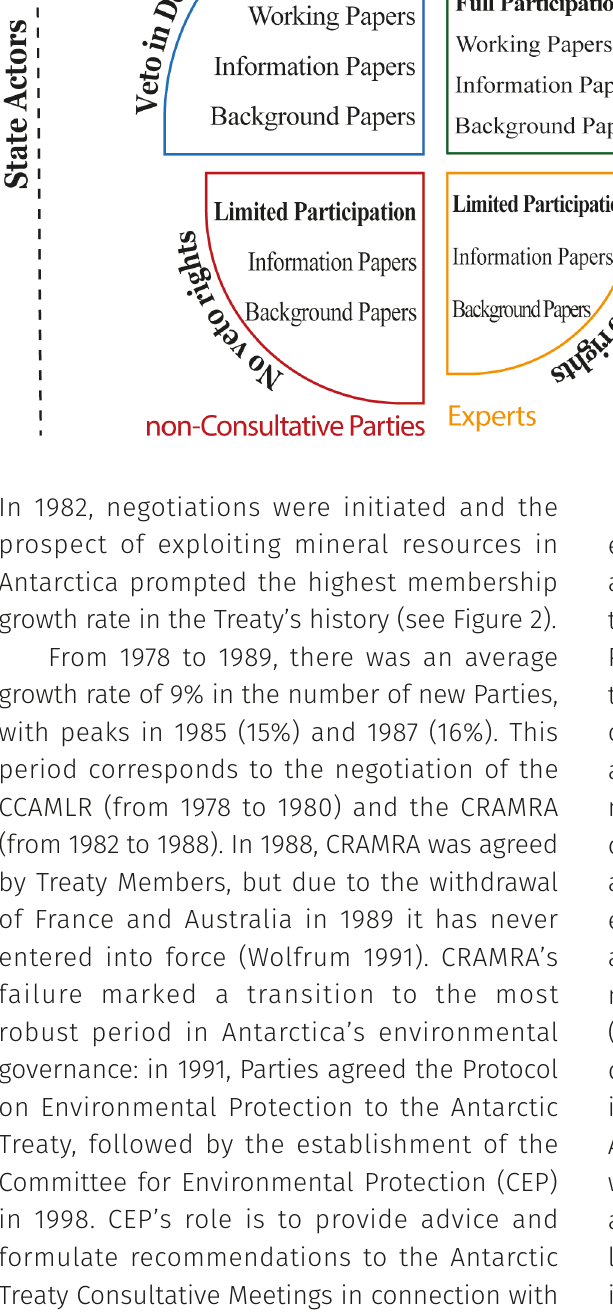
Figure 1. Differences in membership and participation in decision making in the Antarctic